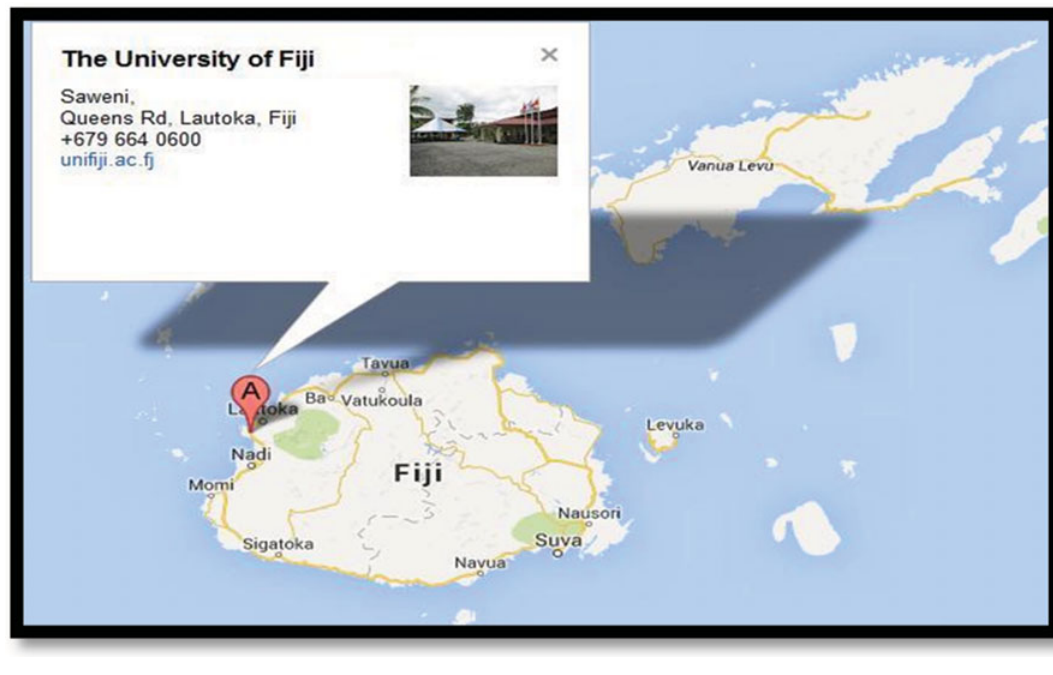
(Colour online) Map of Fiji showing the location of the University of Fiji (https://maps.google.com/maps). TheUniversityofFijiisinitstenthyearofoperationand is one of the main providers of tertiary education in